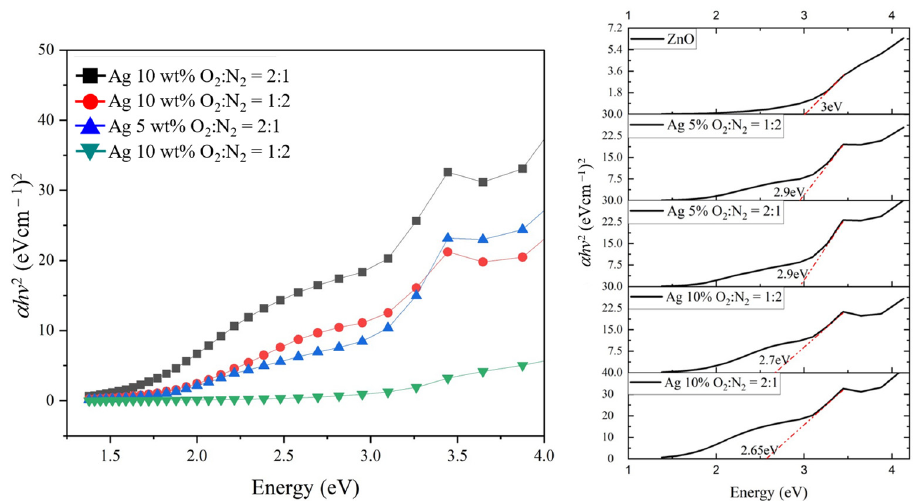
Figure 9. Band gap of ZnO ‐ Ag nanoparticles with different carrier gas ratios and Ag